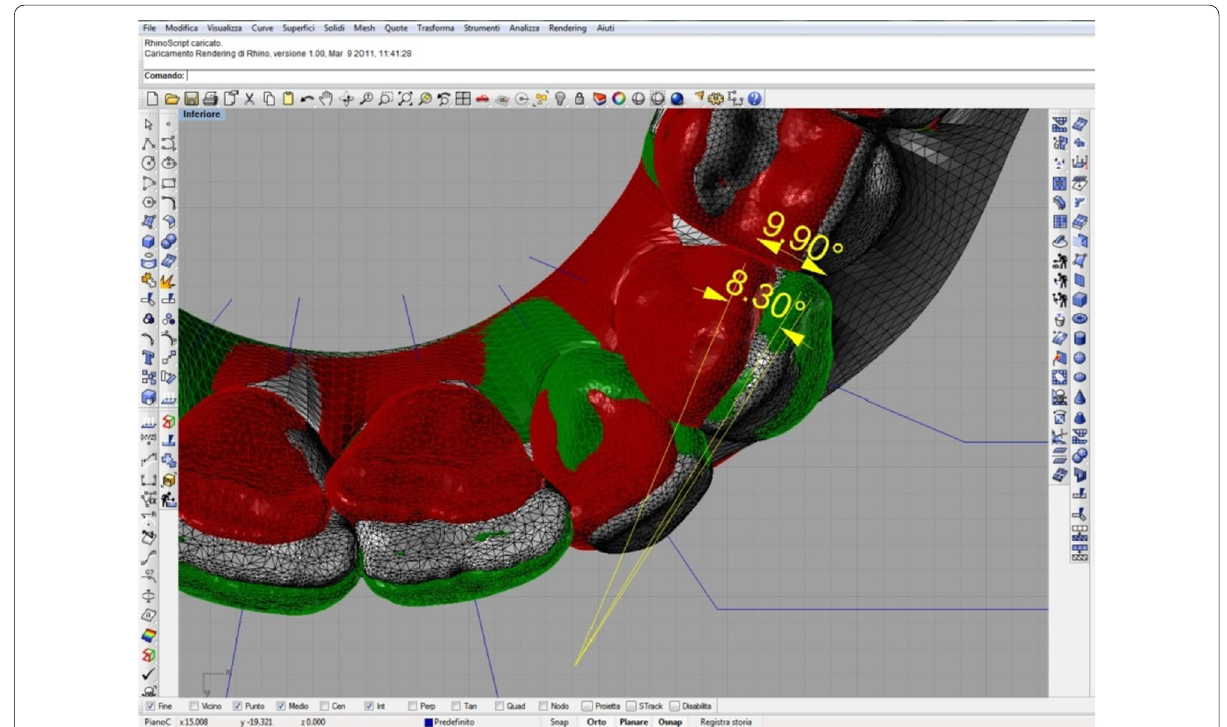
Fig. 2 Discrepancy between planned (green) and obtained (white) rotational movement. Colour red identifies the initial